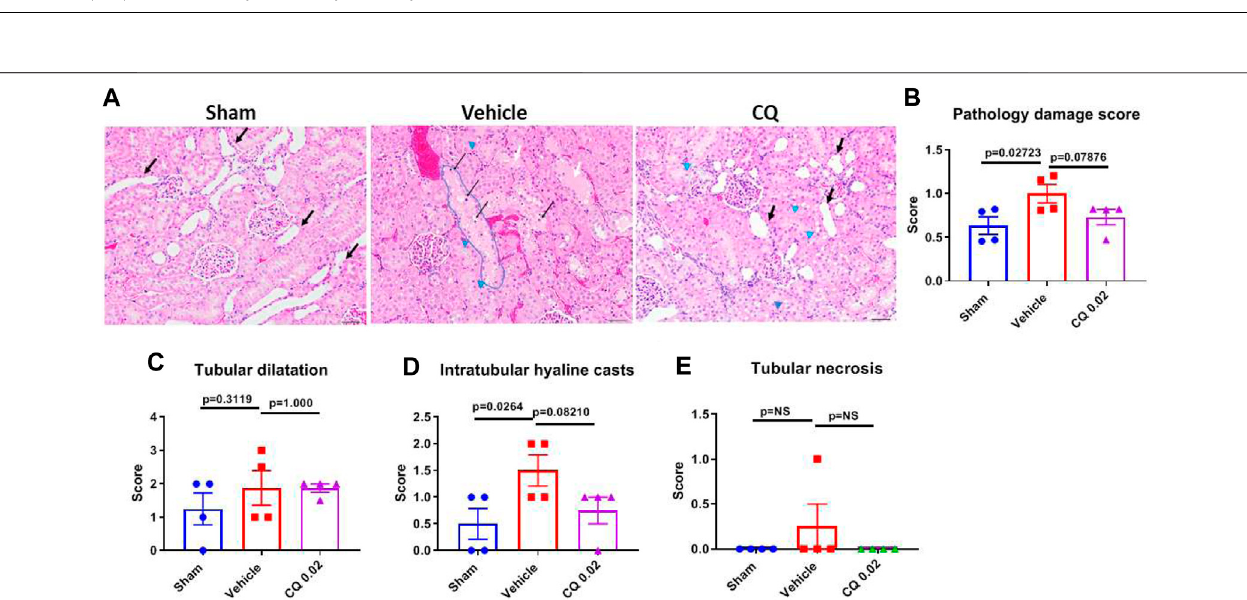
FIGURE 6 | Effect of CQ on kidney tissue damage. (A) , representative microscopy images of H and E stained kidney tissue sections from sham, saline and CQ treatedrats.Someofthedilatedcorticaltubulesaremarkedwith “ blackarrows ” ,vacuoles(clearspaces)intubulesareshownby “ bluearrowheads ” ,ahighlyvacuolated tubuleis “ encircledwithblueline ” ,necroticcellsareindicatedby “ thinblackarrows ” andtubuleswithhyalinecastsareshownwith “ whitearrows ” .Barscale (cid:1) 50 µm. (B) , a graph showing pathological damage score of the kidney tissues in sham, vehicle and CQ treated rats, Calculated on the basis of scores of tubular dilatation (C) , hyaline casts (D) and tubular necrosis or degeneration (E) . Error bars represent mean ± SEM. N (cid:1) 4. Statistical analysis- Ordinary One Way ANOVA and Fisher ’ s test.